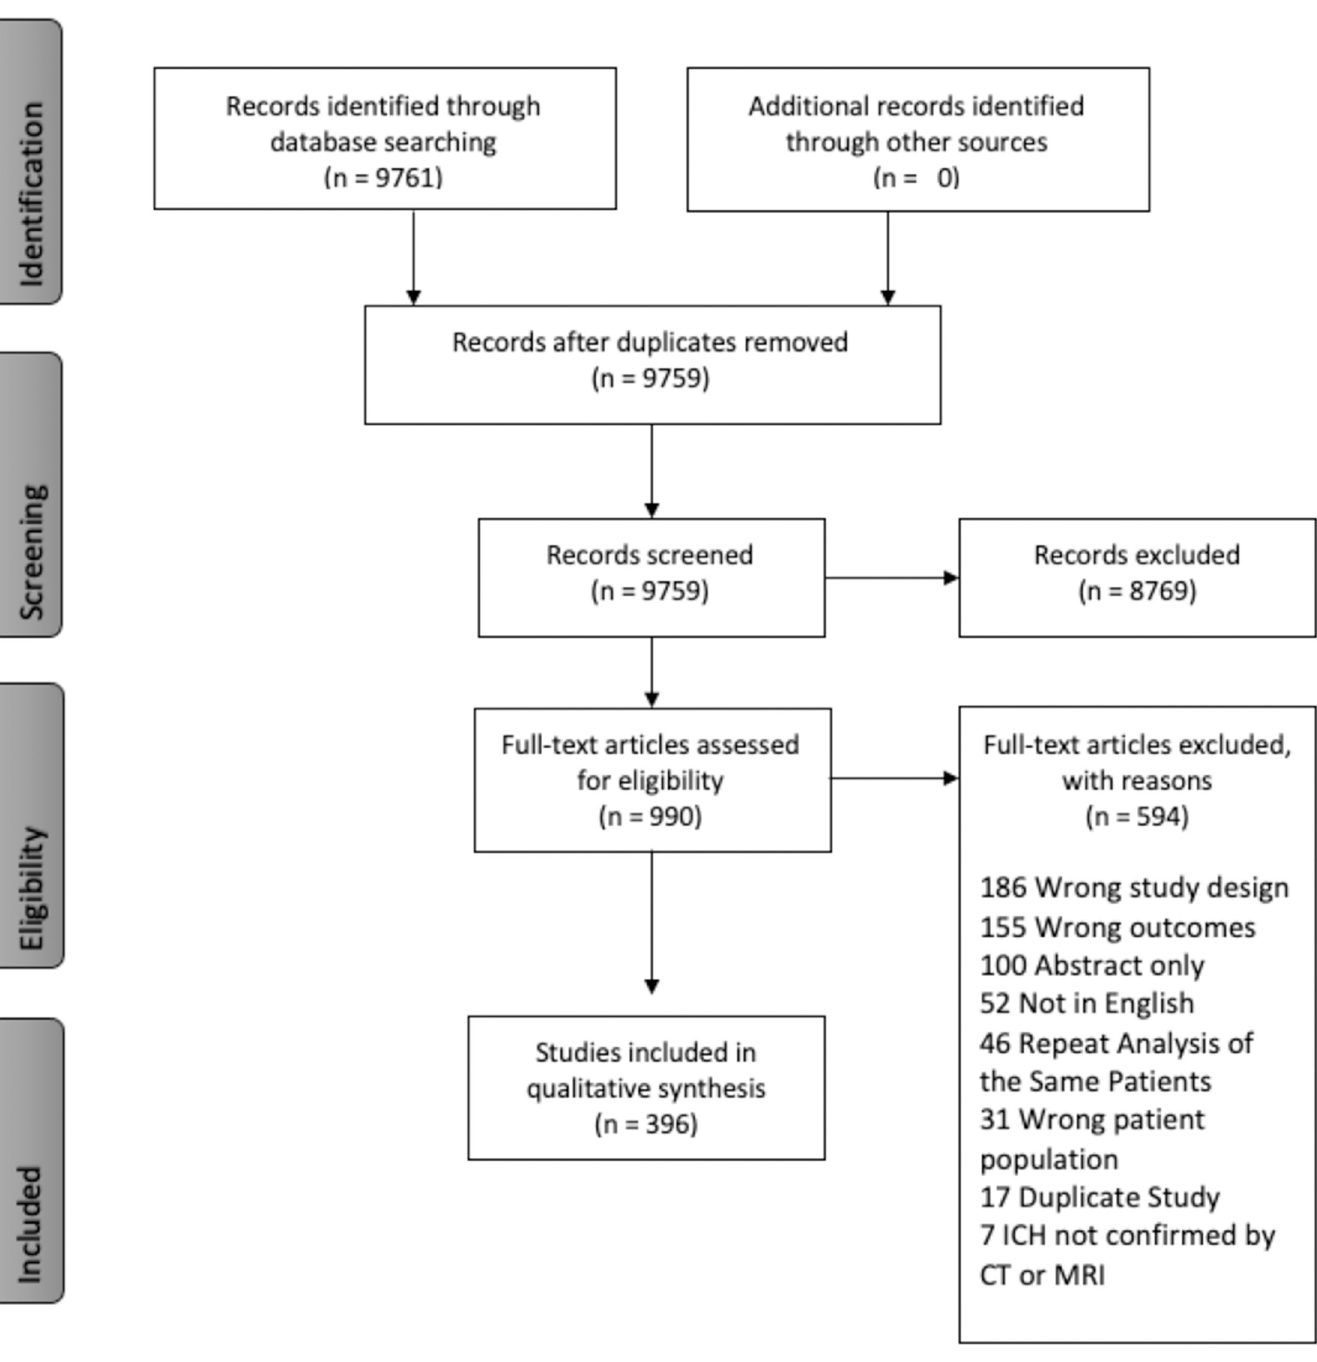
Fig 1. PRISMA flow diagram of article review